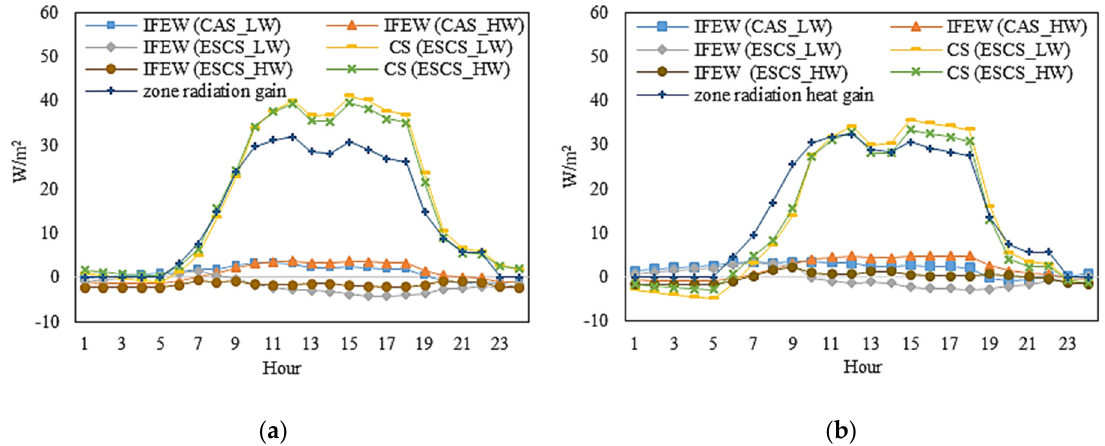
Figure 9. Radiation heat gain in north perimeter zones. ( a ) Radiation heat gain on Beijing cooling design day, ( b ) Radiation heat gain on a typical Nanjing day in transient season. (IFEW—inside face of external wall, CS—cooling ceiling.)